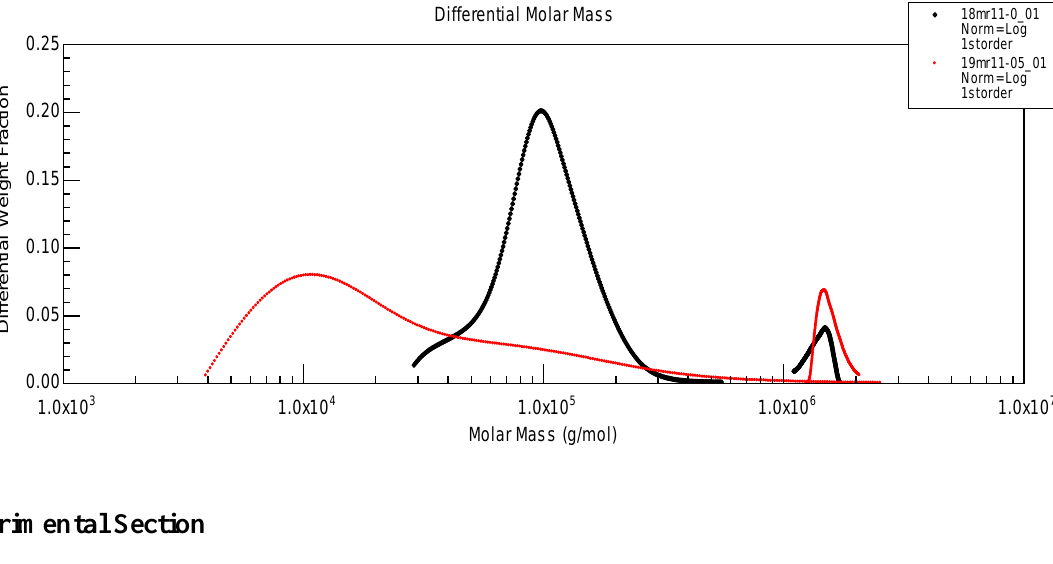
Figure 10. Molecular weight distribution of proteins and HA before (black) and after (red) protease treatment, corresponding to chromatograms shown in Figure